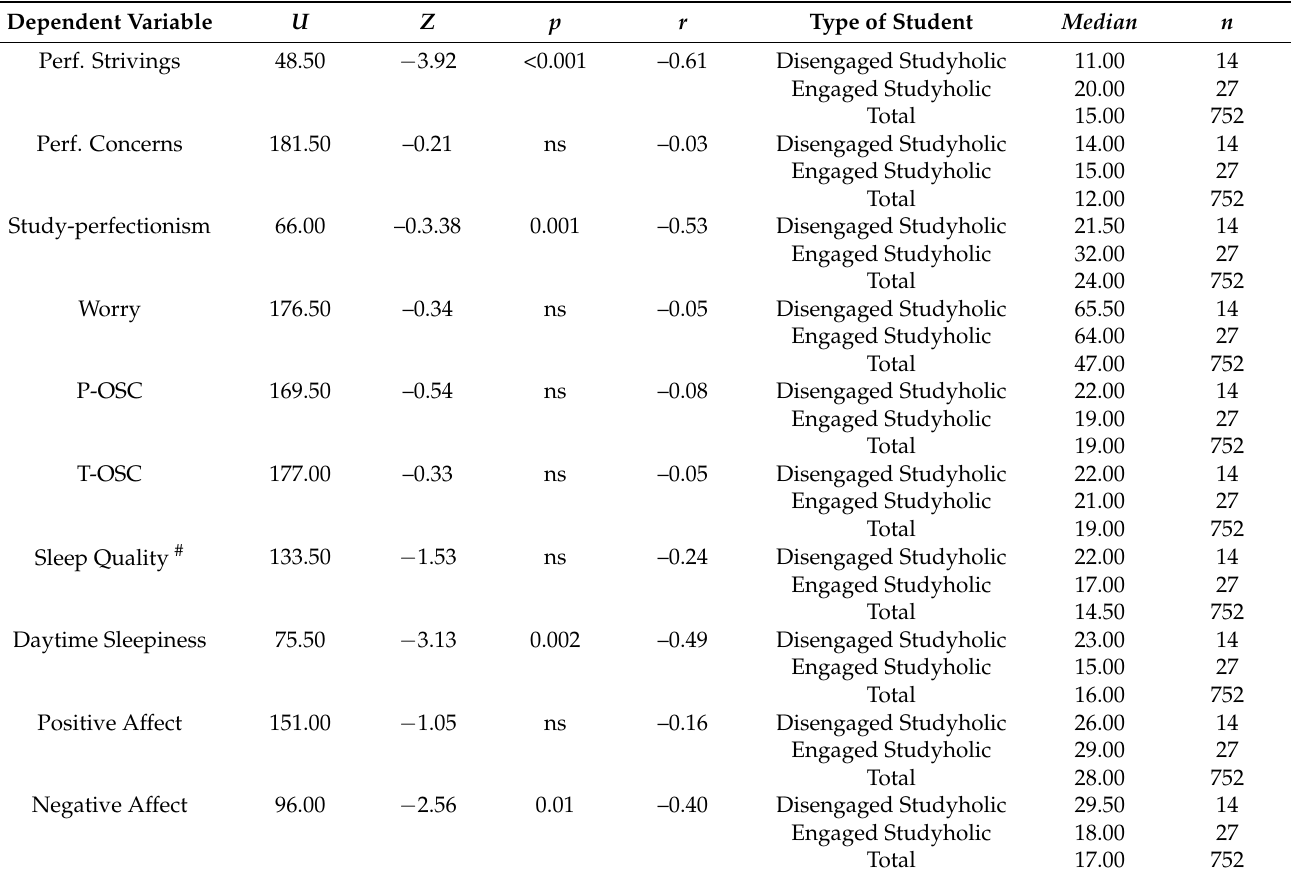
Table 4. Mann–Whitney tests for Studyholism antecedents and outcomes by Studyholic